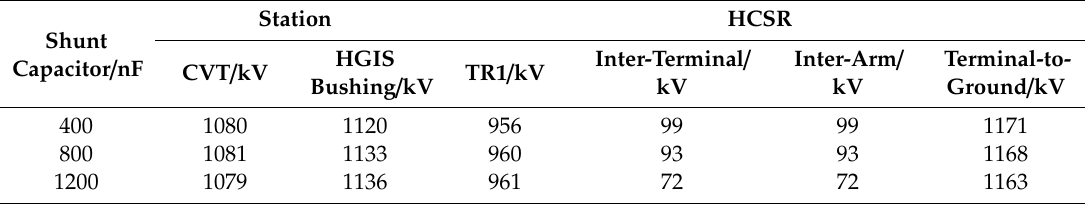
Table 15. Maximum overvoltage of the equipment with the HCSR-FCL working in current sharing state. Shunt Capacitor / nF